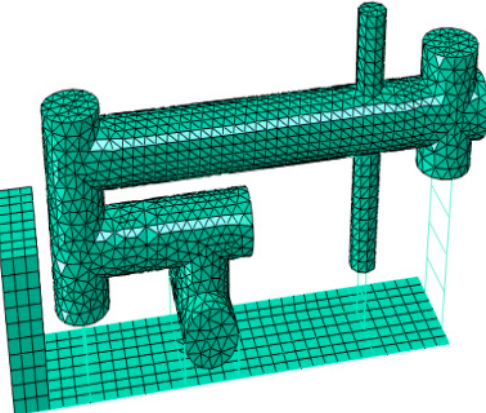
Figure 6. Finite element model of a substation.